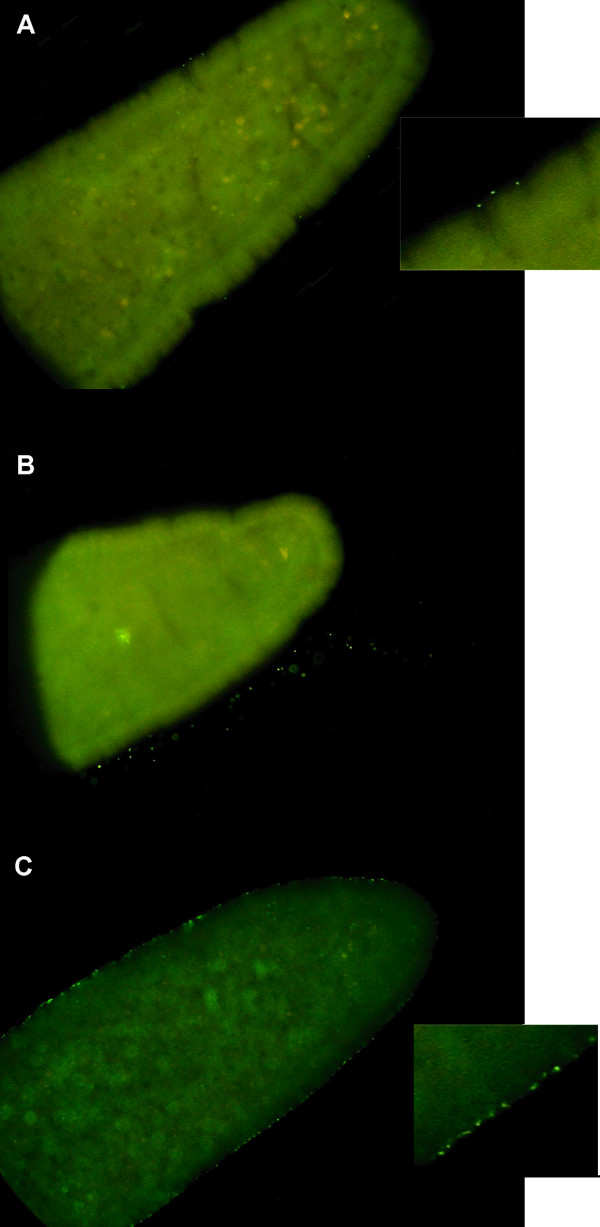
In vitro attachment of fluorescent E. coli strains to isolated intestinal villi. The 97/241.6Δeae REPEC (A) do adhere, but only in small numbers. The insert shows three mutant bacterial cells attached to the enterocytes. DH5α strains (B) do not adhere to the intestinal villi, while B10 strains (C) are strongly adherent. The insert shows multiple E. coli (intense green) attached to the brush border (faint green).